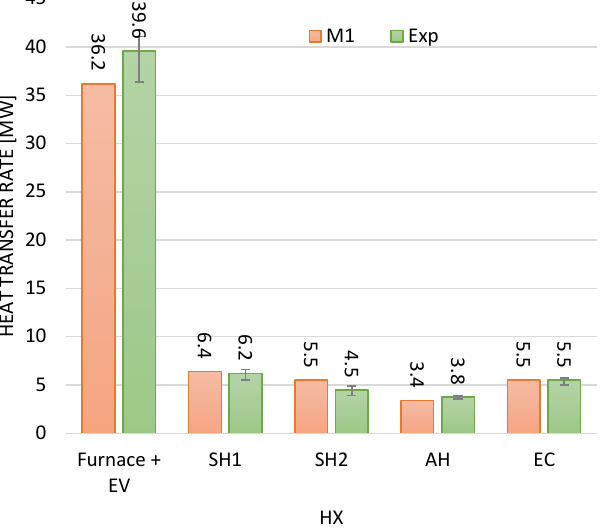
Figure 14. Calculated and measured heat transfer rates per heat exchanger component for industrial-scale biomass-fired boiler 65% load case.